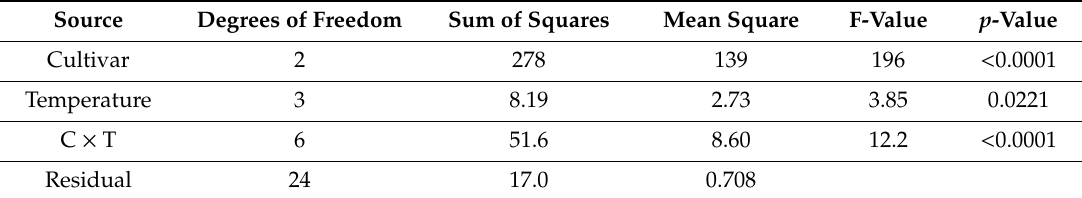
Table A1. Analysis of variance for photosynthetic rates measured at 200 µ mol mol –1 C i for three soybean cultivars grown at 15 ◦ C.